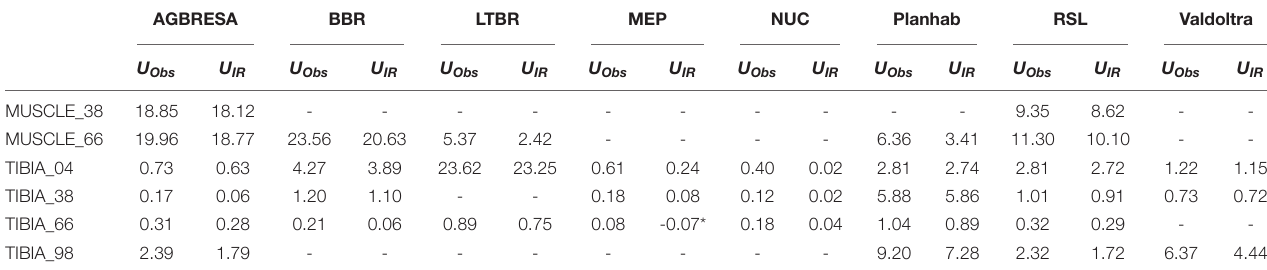
TABLE 4 | Overview about Observed Uncertainty U Obs [% 2 ] and Uncertainty of individual response U IR [% 2 ] by studies and body sites. AGBRESA BBR LTBR MEP NUC Planhab RSL